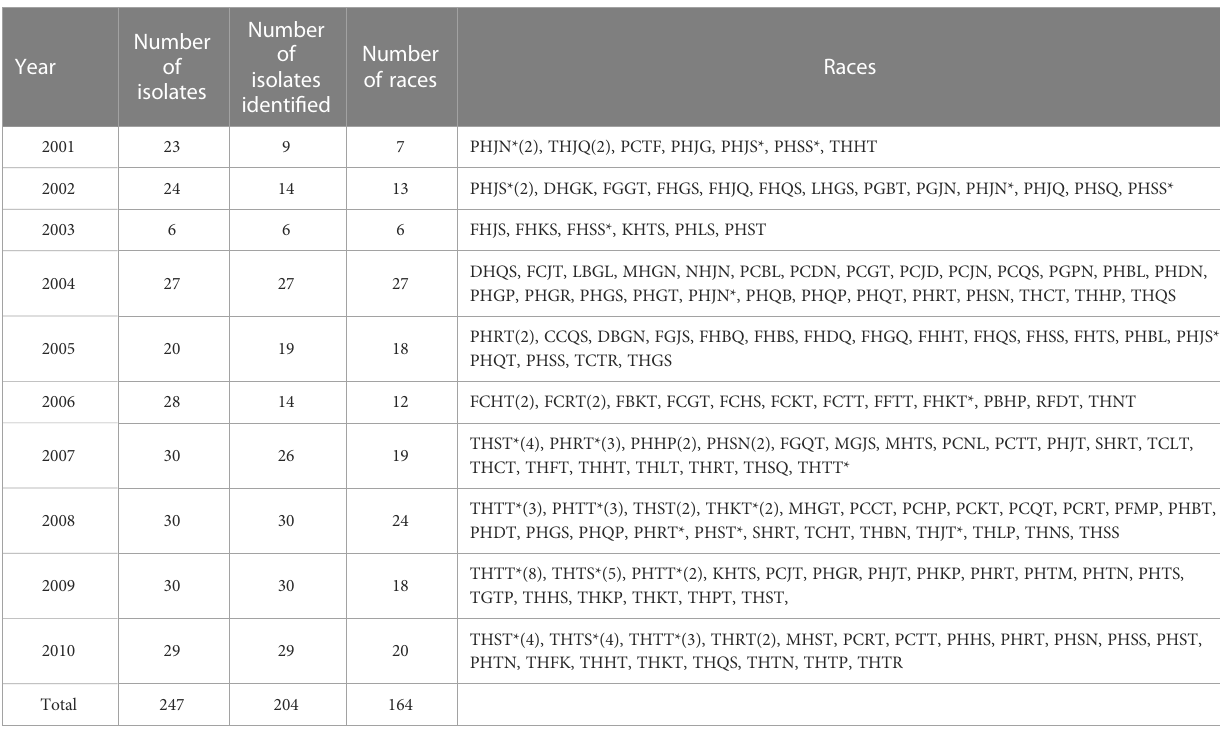
TABLE 1 Races and number of isolates determined each year from 2001 to